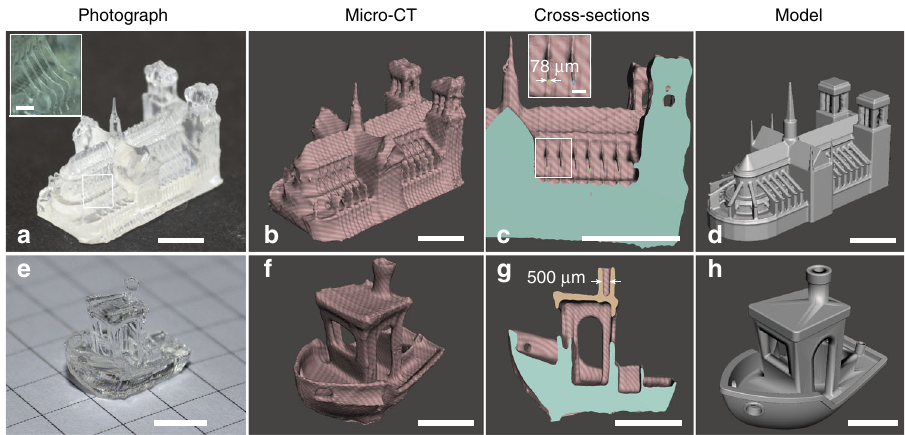
Fig. 3 Printed parts and comparison to model. a Photograph, b micro-CT rendering, c micro-CT cross-section, and d original model for Notre-Dame. A video recording of the printing of Notre Dame is available as Supplementary Movie 3. e Photograph, f micro-CT rendering, g micro-CT cross-section, and h original model for 3DBenchy. Scale bars: 5 mm. In the inset of a the scale bar is 1 mm. In the inset of c the scale bar is 0.5